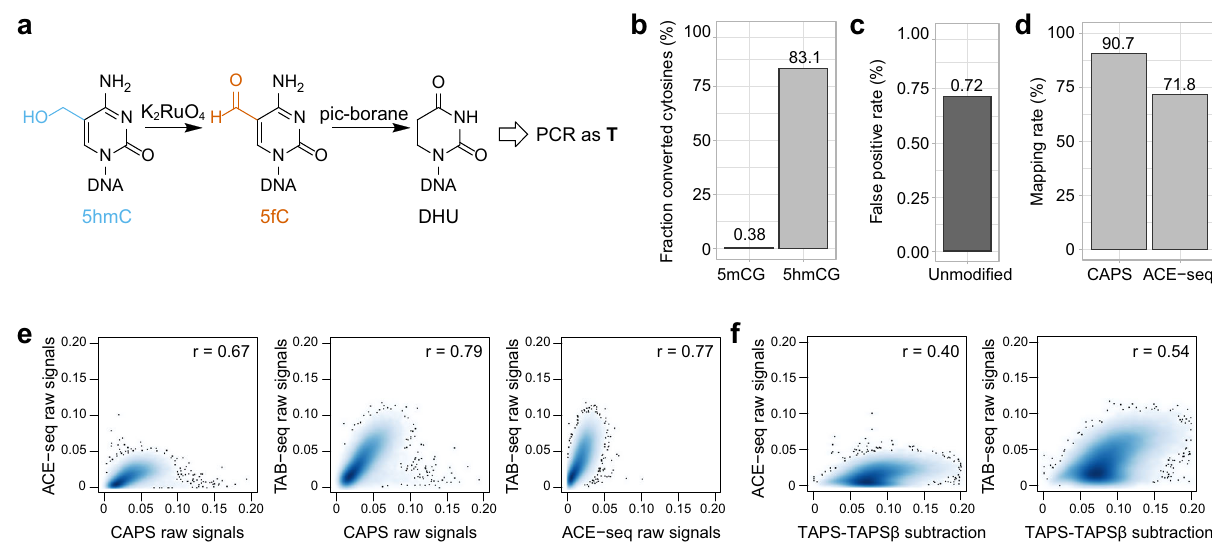
Fig. 2 CAPS for bisul fi te-free 5hmC-speci fi c sequencing. a Schematic demonstration of CAPS. b Conversion rates of CAPS at known 5mCG or 5hmCG positions from CpG-methylated lambda DNA or synthetic spike-in. c False-positive rate of CAPS from 2-kb-unmodi fi ed spike-in. d Fraction of all sequenced read pairs in CAPS and ACE-seq mapped to the reference mouse genome. e Correlation density plot between CAPS, TAB-seq, and ACE-seq in 10-kb bins. The color scale represents density. f Correlation density plot between TAPS − TAPS β subtraction and TAB-seq or ACE-seq in 10-kb